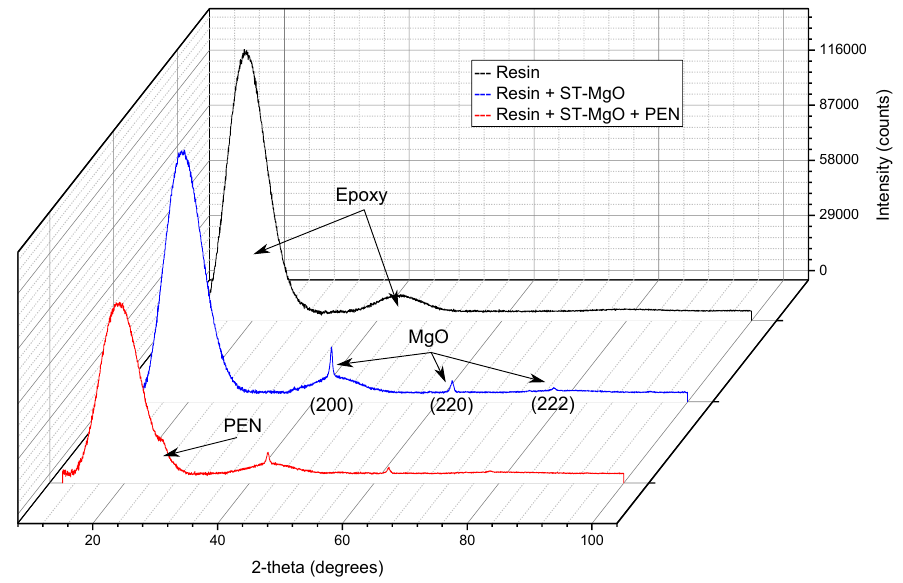
Figure 8. X-ray diffraction patterns depending on the different component addition.